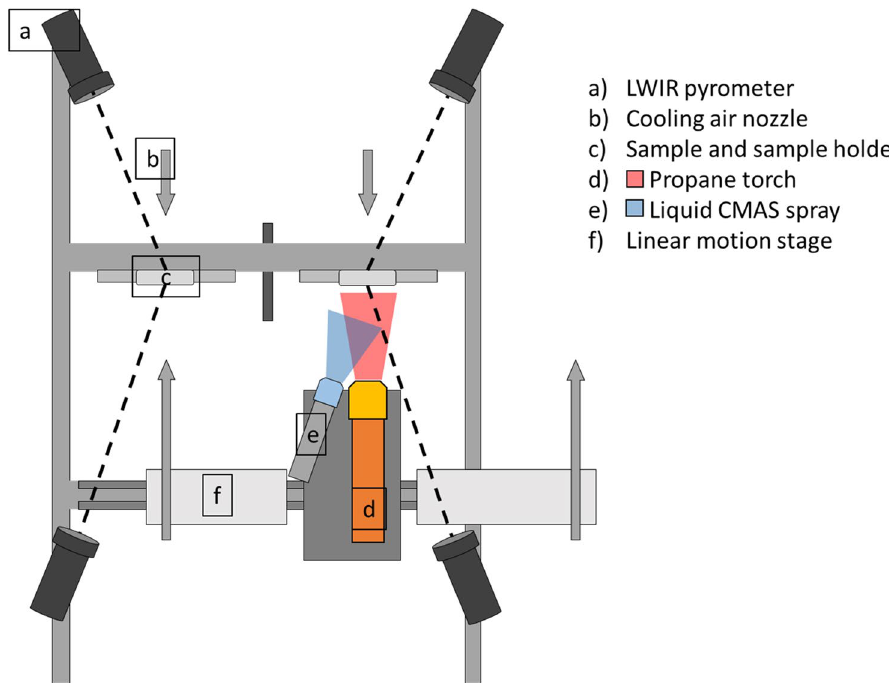
Fig. 1 Rough schematic of gra- dient rig testing setup. Long wavelength infrared pyrom- eters are directed at the front (TBC) and back (superalloy) of the sample. An aerosolizing spritzer sprays liquid nitrate based CMAS at the sample dur- ing sample heating. A moving stage moves the propane-oxy- gen torch, CMAS spritzer, and front-side air cooling nozzles from one sample to the